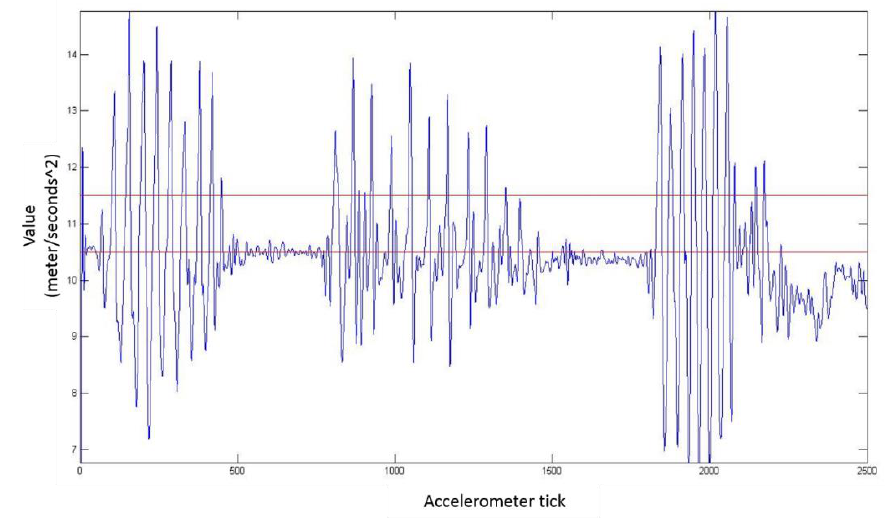
Figure 8. Using two threshold method on real accelerometer